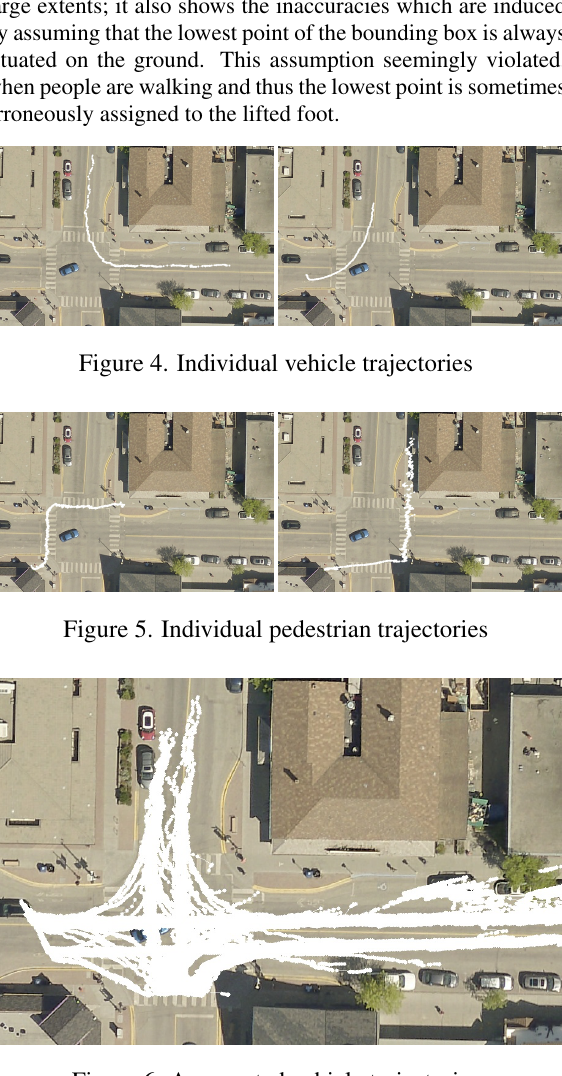
Figure 6. Aggregated vehicle